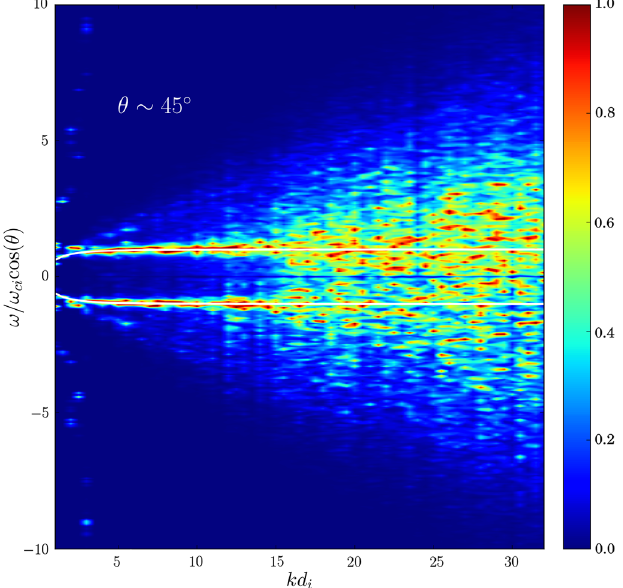
FIG. 11. Space-time Fourier spectrum of the x component of the generalized Elsässer Z þ − (positive frequency) and Z − (negative frequency) fields at θ ∼ 45 °. The solid white line is the theoretical ion-cyclotron linear dispersion relation. The color map is normalized to the maximum value of the spectrum at each fixed k